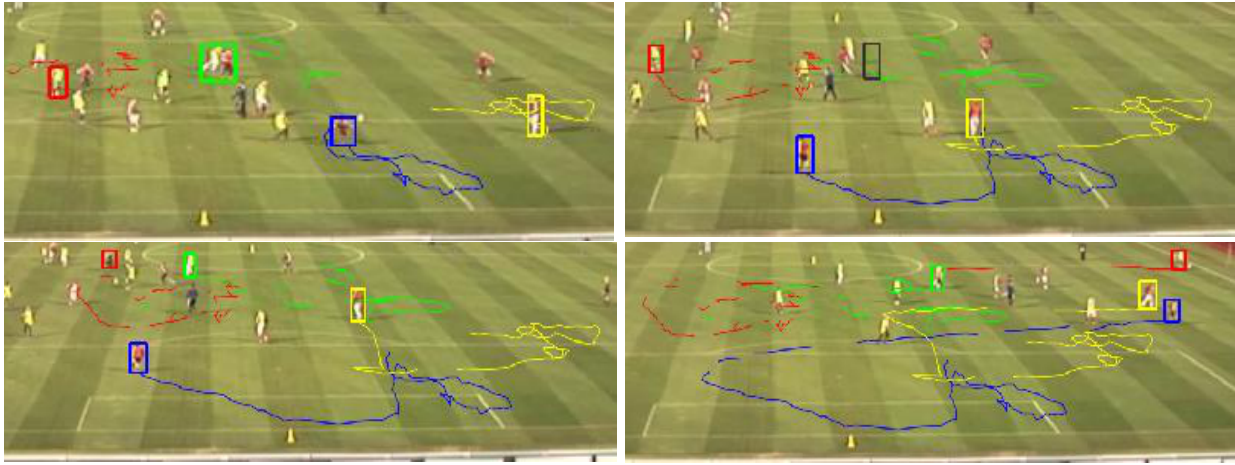
Figure 13. The resulting trajectories of our approach showing the ability to deal with